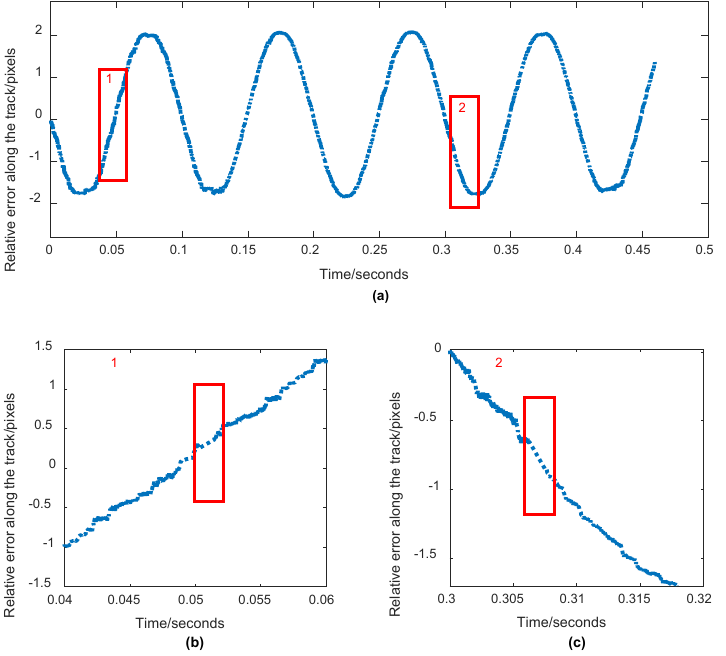
Figure 12. The 10-Hz jitter detection curves by sequential disparity maps after interpolation. ( a ): The whole detected results after interpolation; ( b ): the local amplification of rectangular area 1 in ( a ); ( c ): the local amplification of rectangular area 2 in ( a